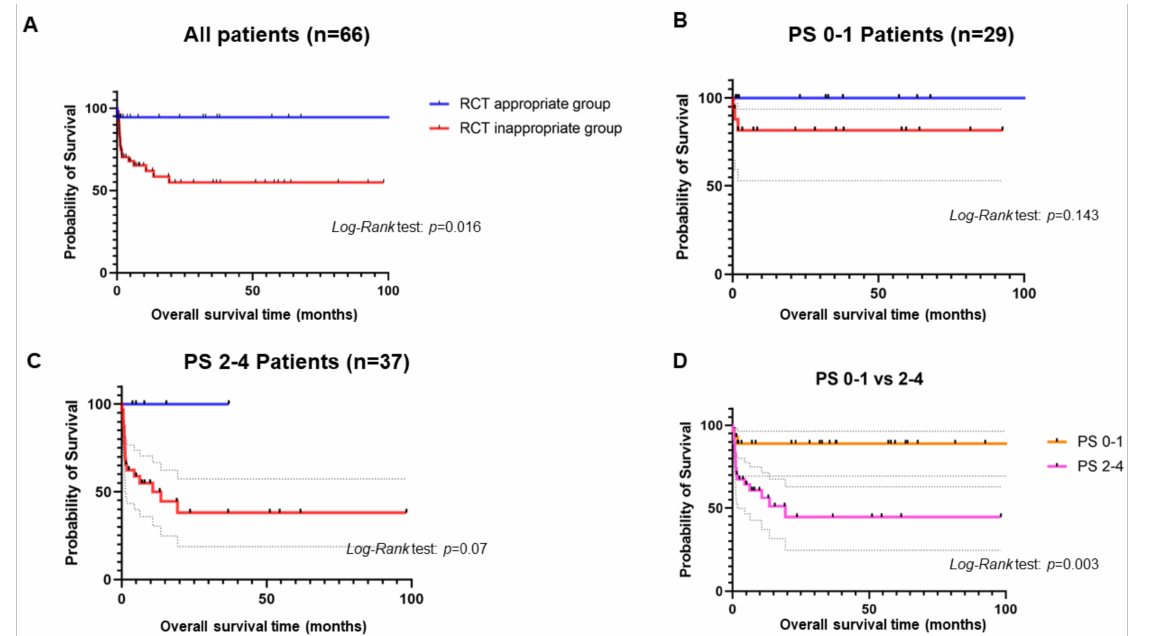
Figure 1. Kaplan–Meier curves. ( A ) shows the comparison of OSs between RCT appropriate and inappropriate groups among IE patients. ( B ) shows the comparison of OSs between RCT appropriate and inappropriate groups among IE patients with PS 0-1. ( C ) shows the comparison of OSs between RCT appropriate and inappropriate groups among IE patients with PS 2-4. ( D ) shows the comparison of OSs between IE patients with PS 0-1 and those with PS 2-4.